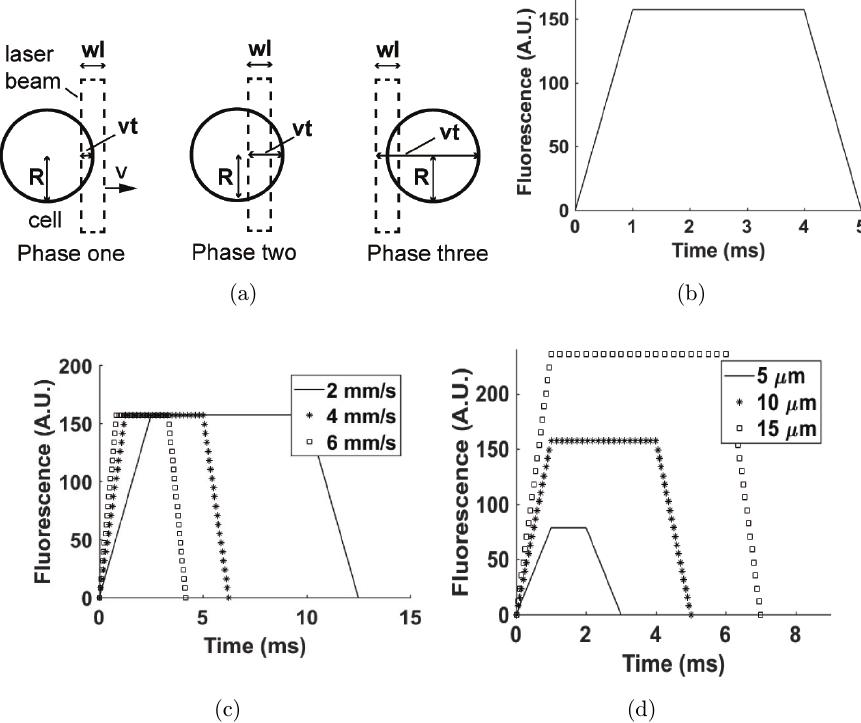
Fig. 1. Area-based single cell model. (a) Phases of cell passing the laser beam in area-based model. (b) Typical area-based model of single cell. In this model, R ¼ 10 (cid:1) m, W ¼ 5 (cid:1) m, v ¼ 5 mm/s and k ¼ 1 mV/ (cid:1) m 2 . (c) Area-based model of single cell with di®erent velocities. In this model, R ¼ 10 (cid:1) m, W ¼ 5 (cid:1) m and k ¼ 1 mV/ (cid:1) m 2 . (d) Area-based model of single cell with di®erent radiuses. In this model, W ¼ 5 (cid:1) m, v ¼ 5 mm/s and k ¼ 1 mV/ (cid:1) m 2 . A.U. denotes arbitrary